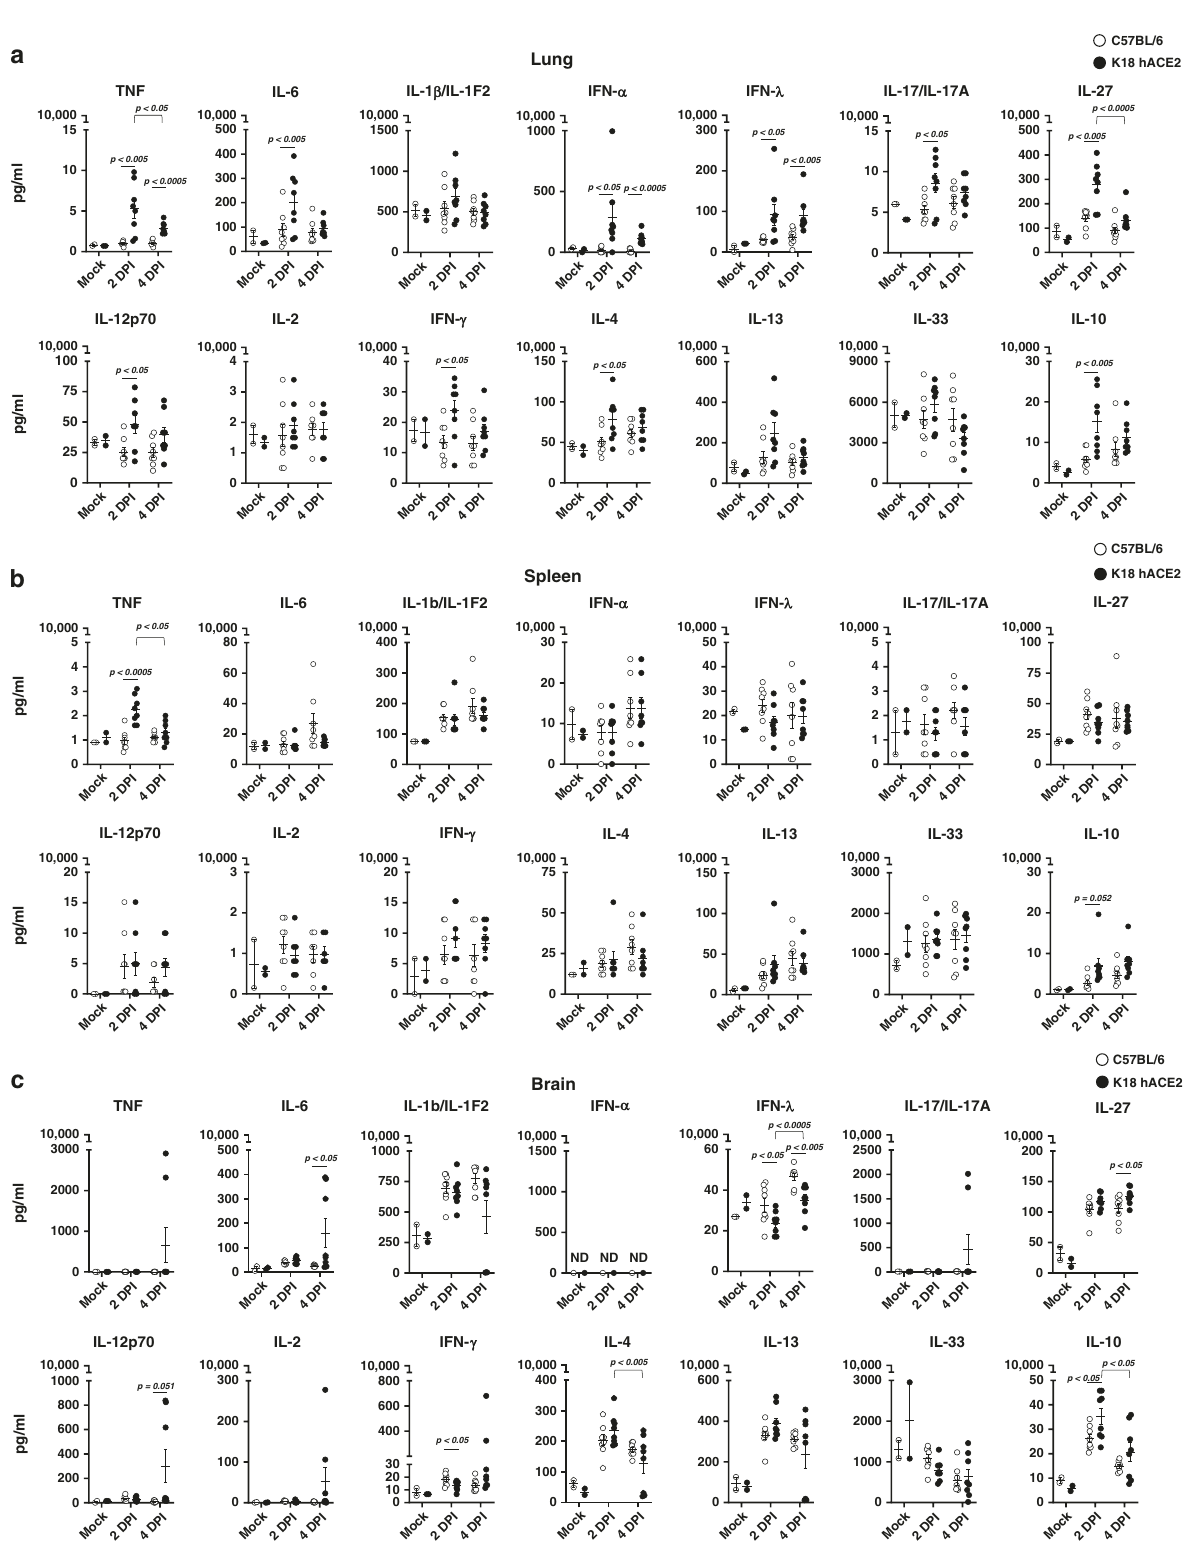
Fig. 3 SARS-CoV-2-infected K18 hACE2 transgenic mice show a marked cytokine storm in selected tissues. a Lungs, b spleen, and c brain. Student ’ s t test, two-tailed, C57BL/6 vs. K18 hACE2 p < 0.05; p < 0.005; p < 0.0005; two-way ANOVA C57BL/6 or K18 hACE2 transgenic mice over time, p < 0.05; p < 0.005; p < 0.0005, M ± SEM, n = 8 mice (50:50 male:female per time-point studied, except mock n = 2 mice). DPI days post infection. Data are representative over two independent experiments. Source data are provided as a Source Data fi